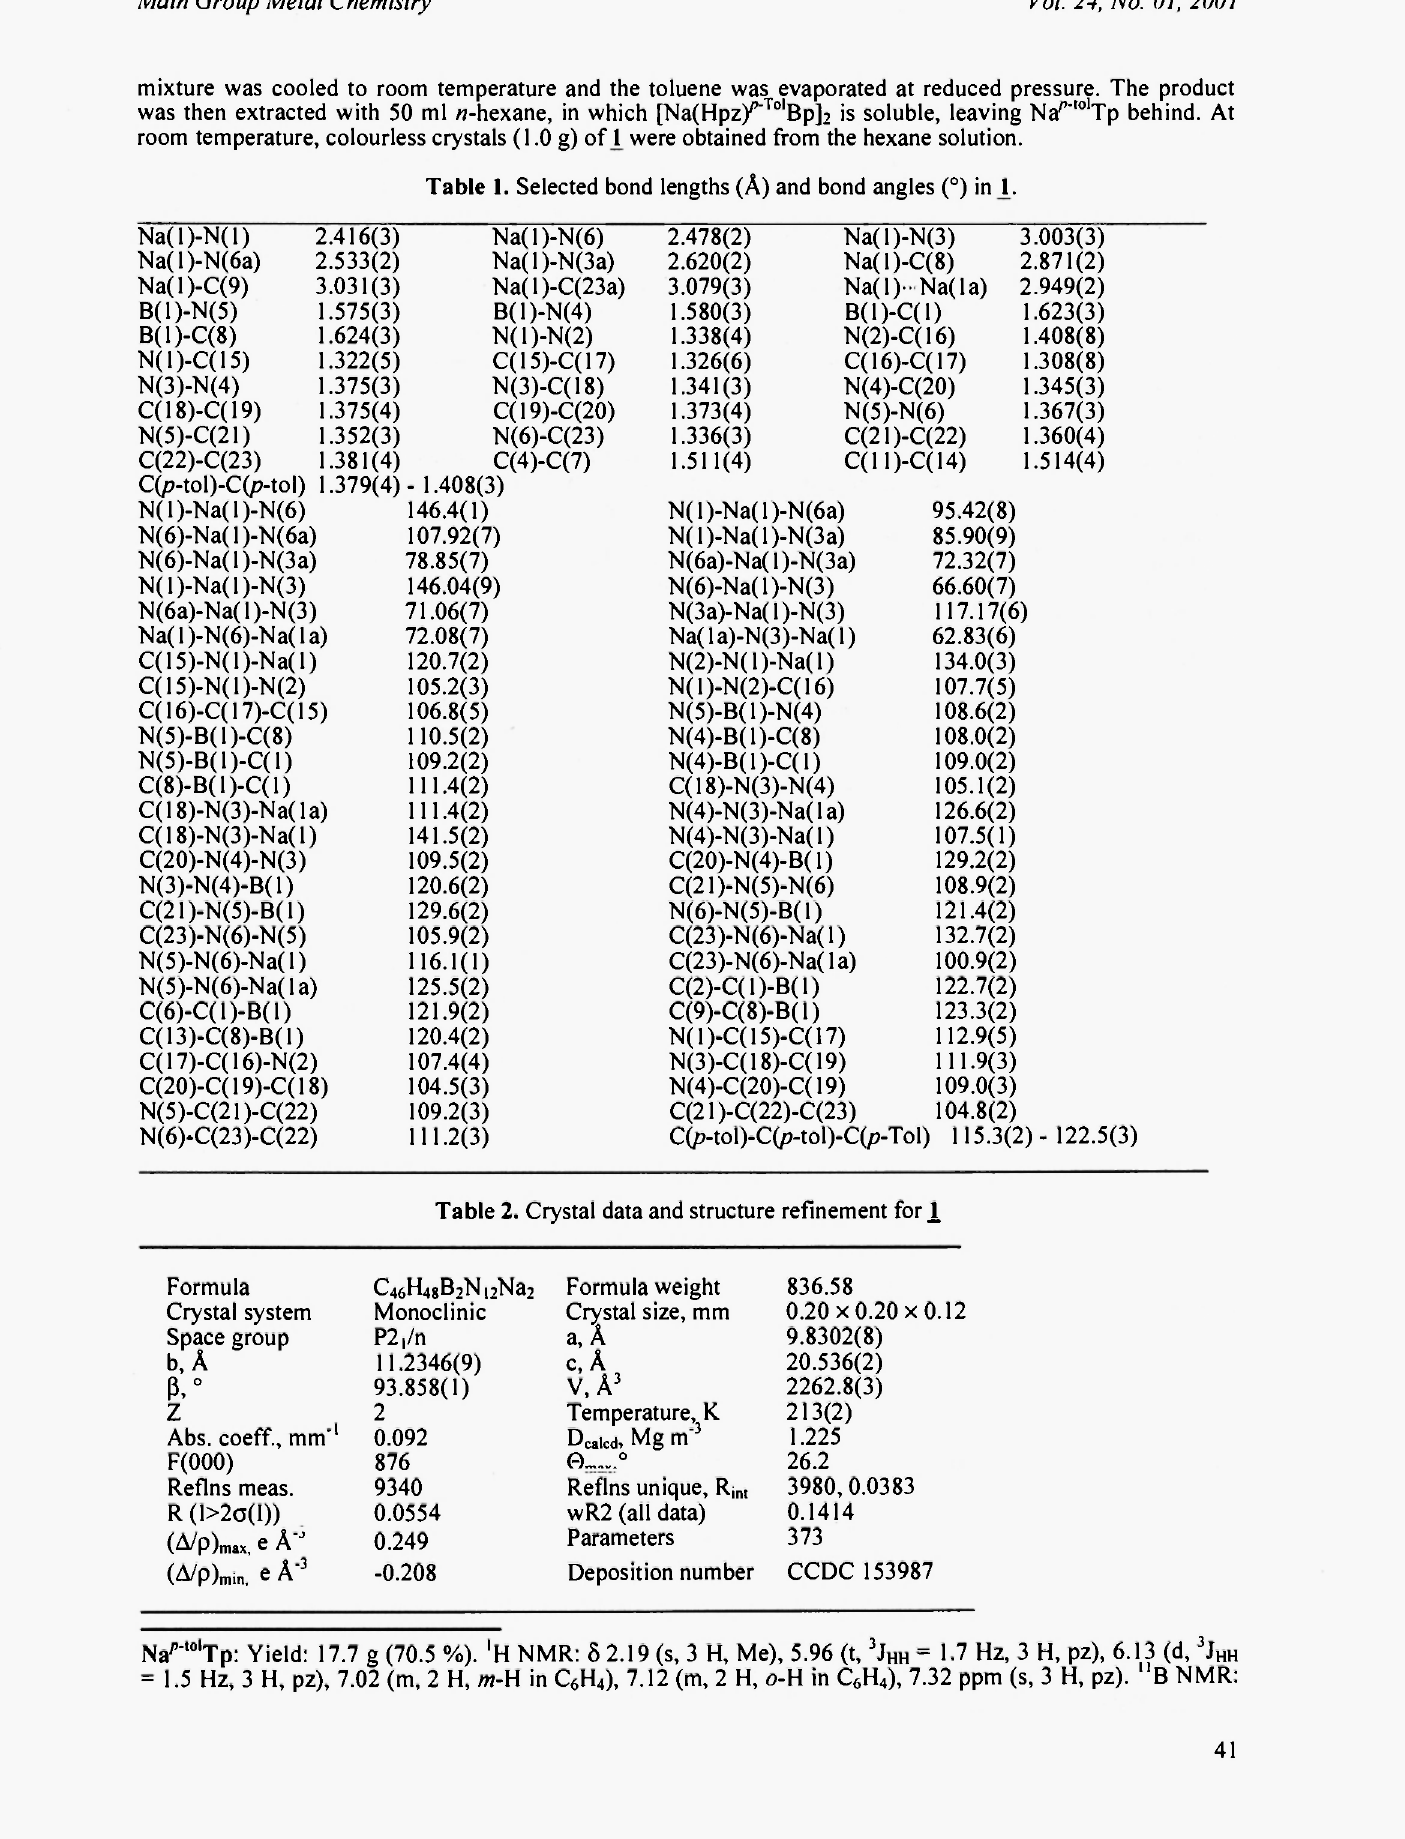
Table 2. Crystal data and structure refinement for